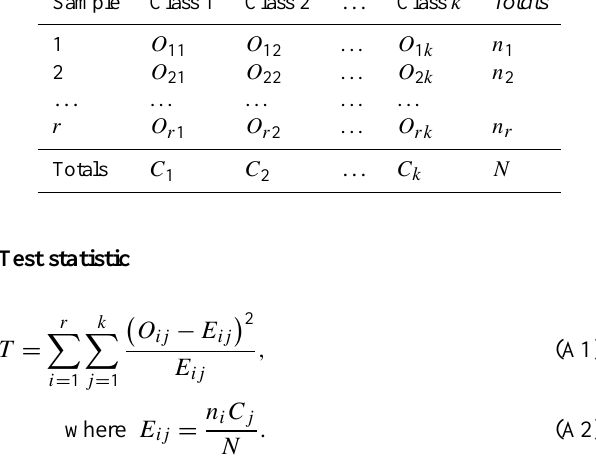
Table A1. Notation used in the chi-square test for r independent samples. Sample Class 1 Class